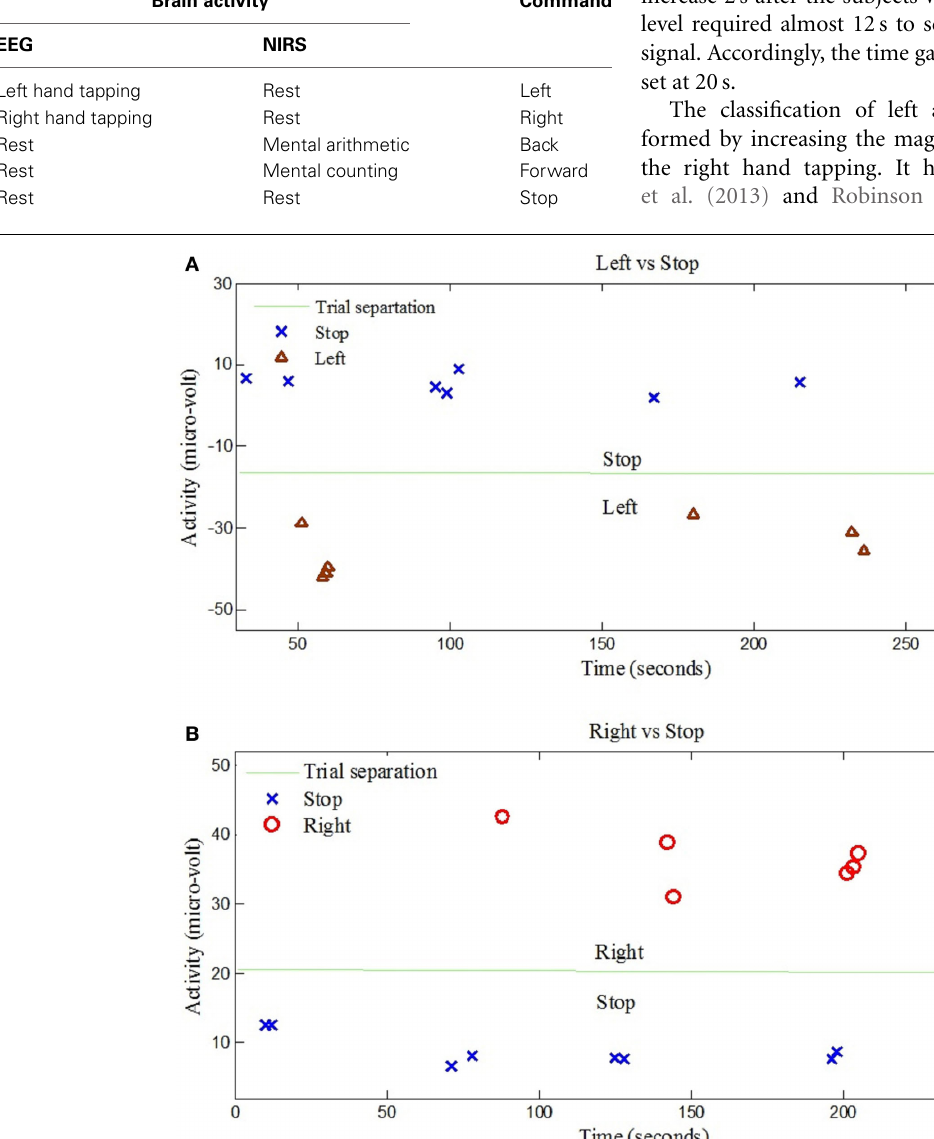
Frontiers in Human